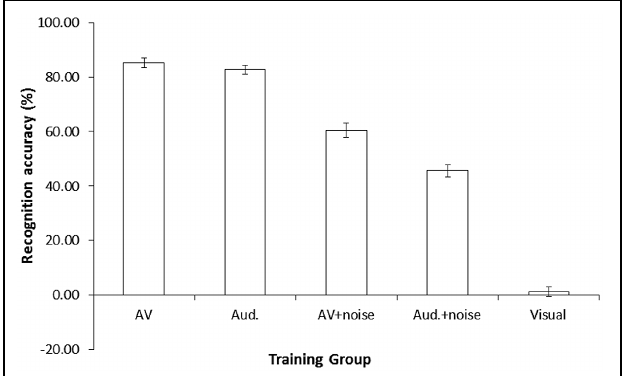
FIGURE 4 | Mean % recognition accuracy of accented speech per group, during the training session in Study 1. Error bars represent ± 1 SE. AV, audiovisual; Aud.,